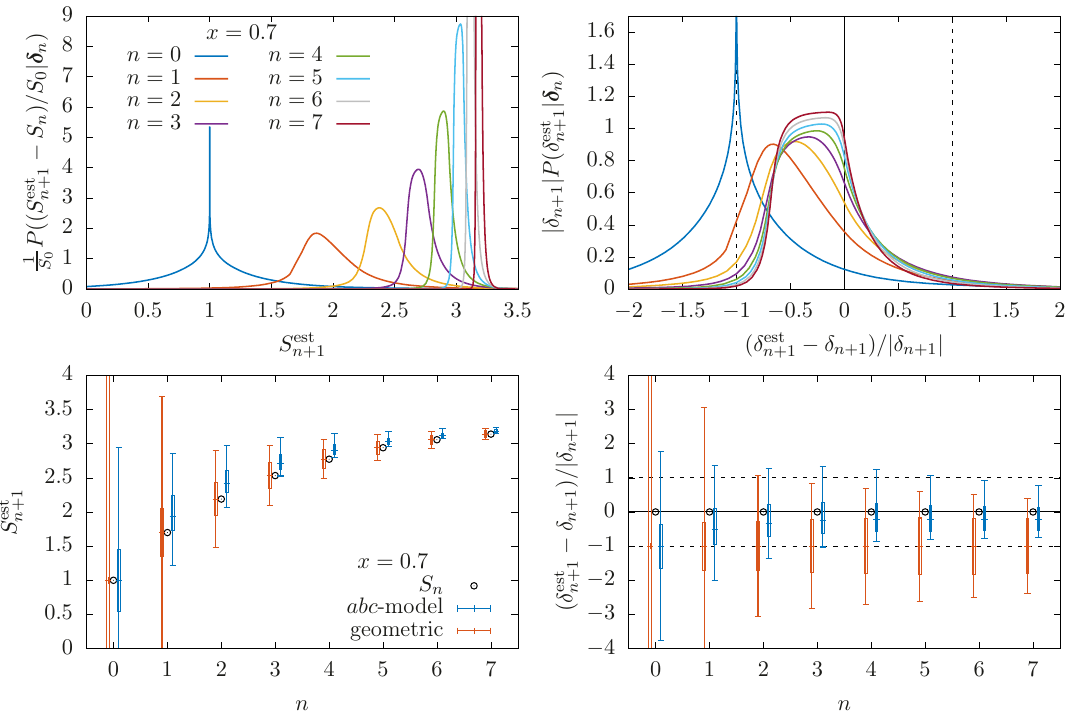
for different Figure 3 . Top left panel: the probability distribution from the abc -model for S est n +1 values of n for the geometric series with x = 0 . 7 . Top right panel: the same as the left panel, but we show the probability for the scaled deviation from the known correction ( S est − S n +1 ) / | S n +1 − S n | . n +1 Bottom left panel: the median (plus), 68% CI (errorbox) and 95% CI (errorbar) for the posterior of , computed from the abc (blue) and geometric (red) models using information on the previous S est n +1 orders. The exact values of S are shown as black circles. Bottom right panel: the same as the left n panel, but the exact S value is subtracted from S est and the difference is normalised by | S n n +1 − S n | n +1